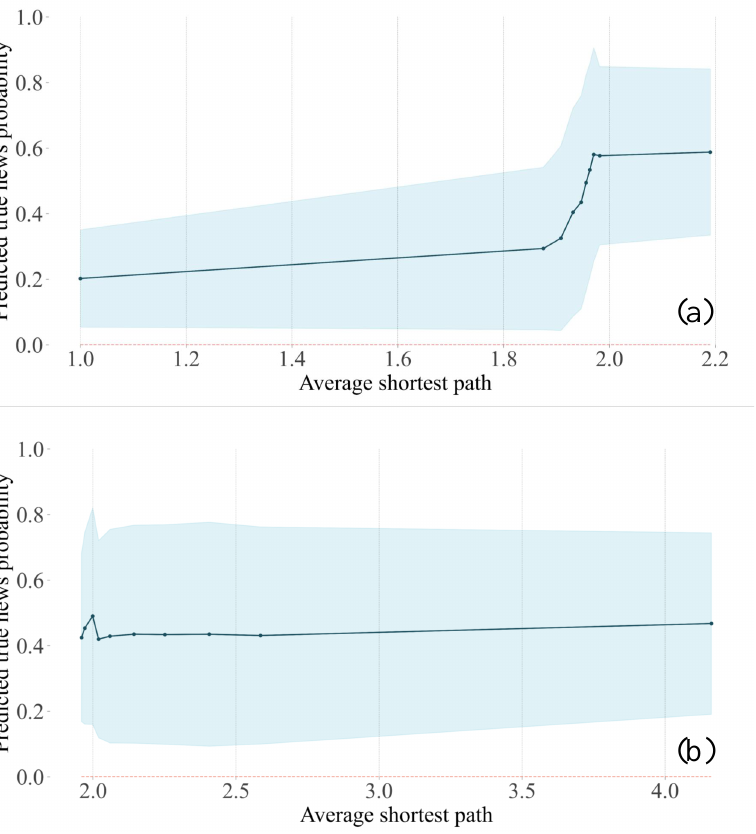
Figure 3. Partial dependency plot for the Gossipcop dataset. ( a ) Cut-off time is 2.4 h. ( b ) Cut-off time is 12 h. The shaded area represents the confidence interval.